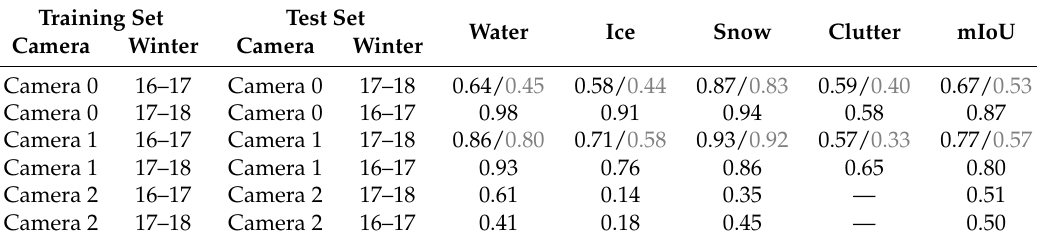
Table 18. Results (IoU) of cross-winter experiments. We compare our results with the Tiramisu Network [34] (shown in grey). Cameras 0 and 1 monitor lake St. Moritz while camera 2 captures lake